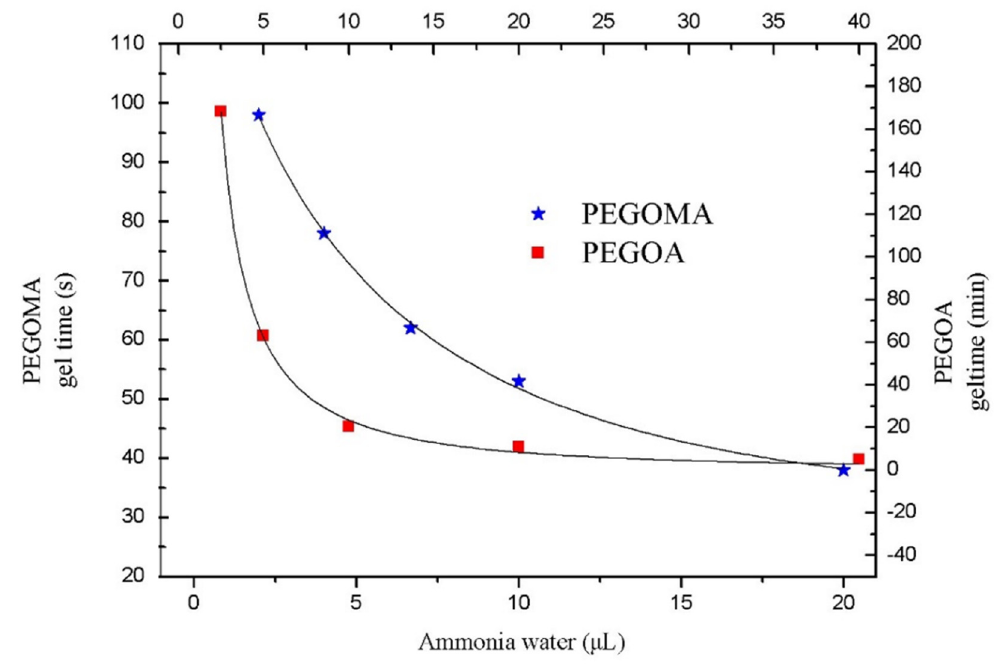
Figure 2. Gelation time changes of PEGOMA and PEGOA hydrogels with the added amount of ammonia water.